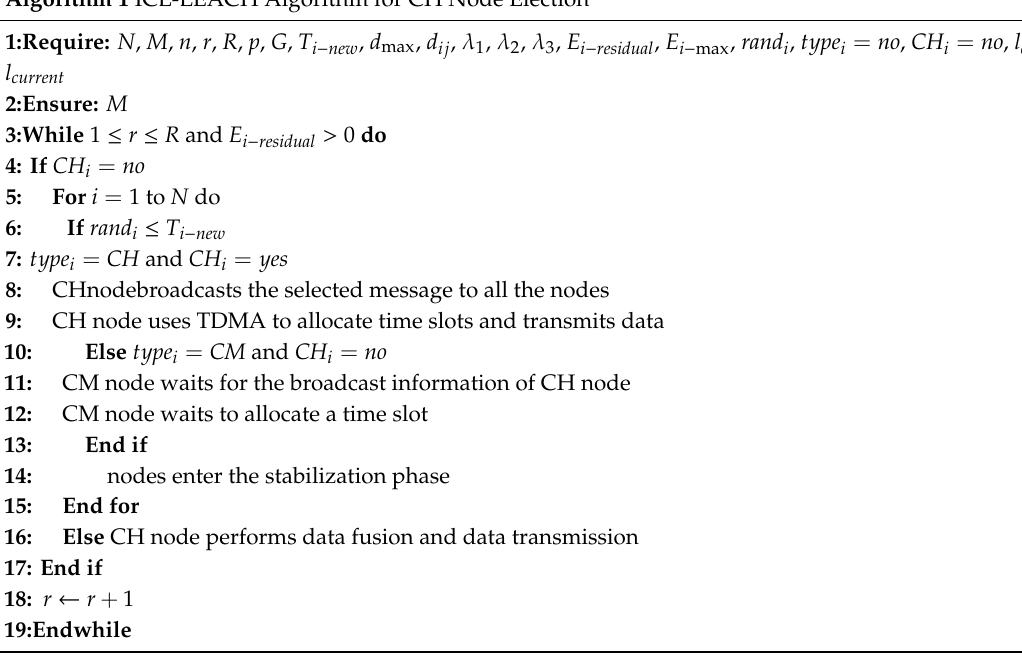
Algorithm 1 ICL-LEACH Algorithm for CH Node